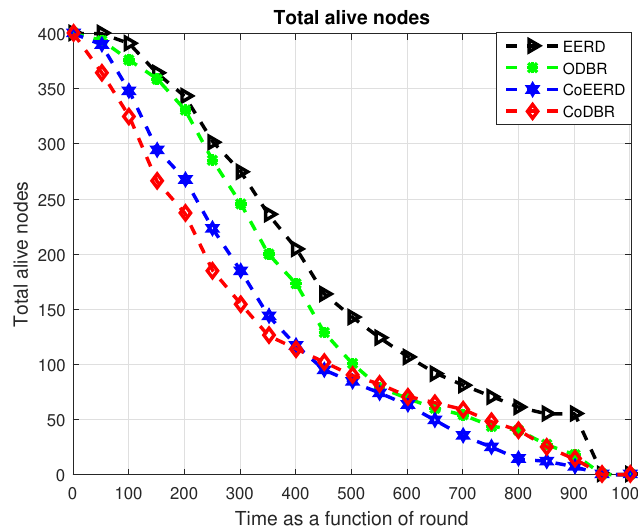
Figure 14. Total number of alive